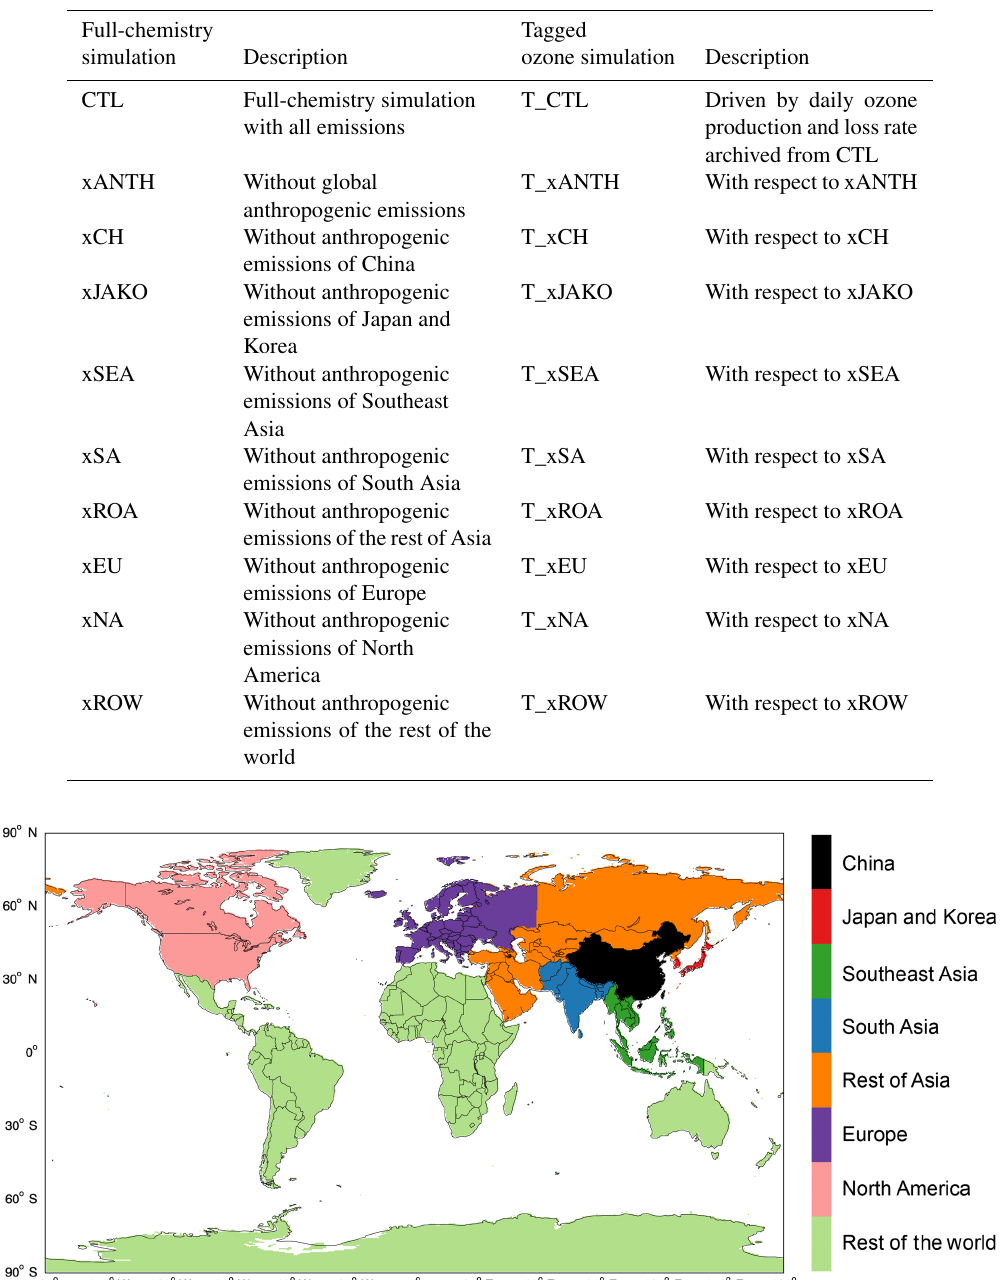
Table 2. Model simulations.